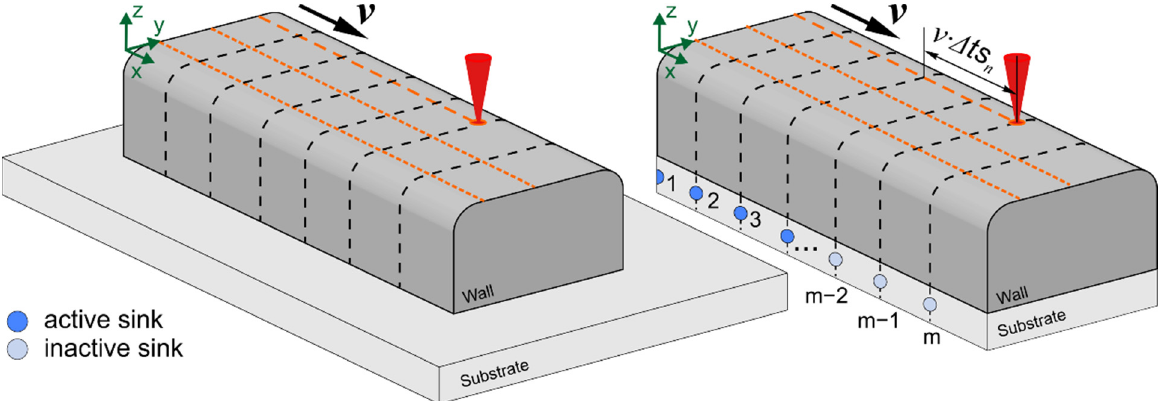
Figure 4. Scheme of the introduction of heat sinks (the sinks are shown for the current